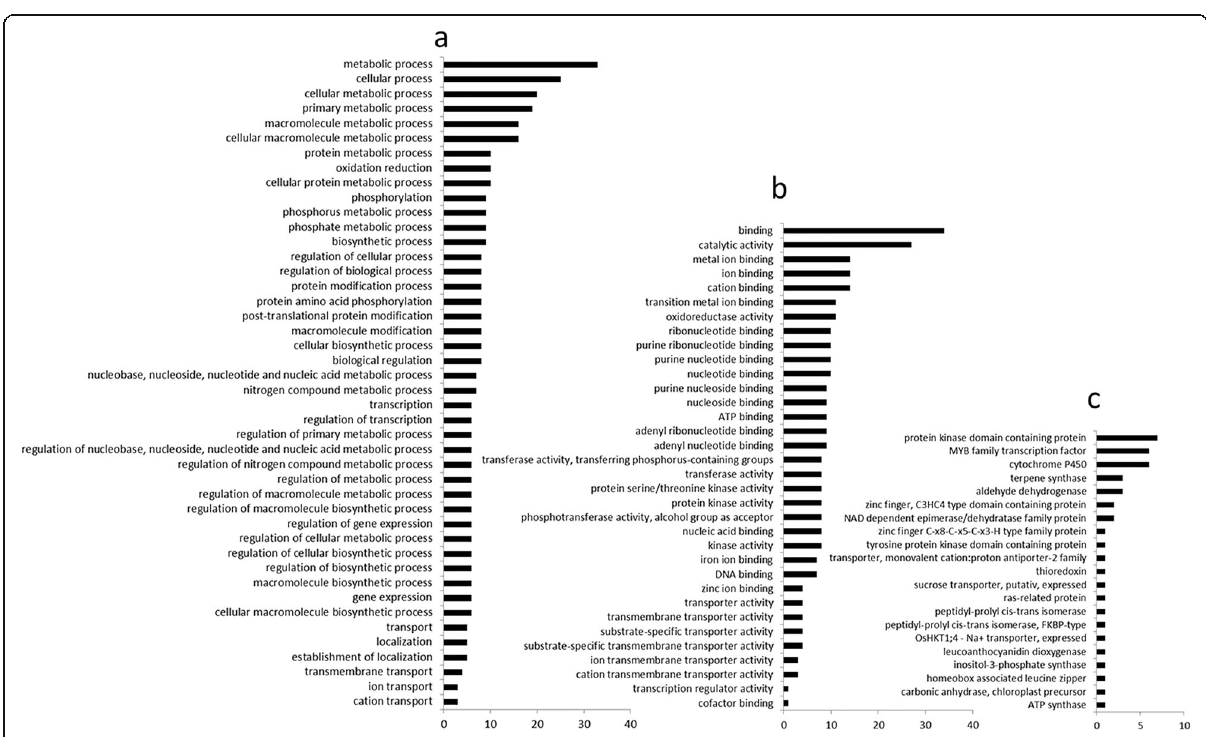
Fig. 3 The GO terms represented in the “ biological process ” (a) and “ molecular function ” (b) GO categories, and the putative encoded proteins (c) for the 43 identified candidate